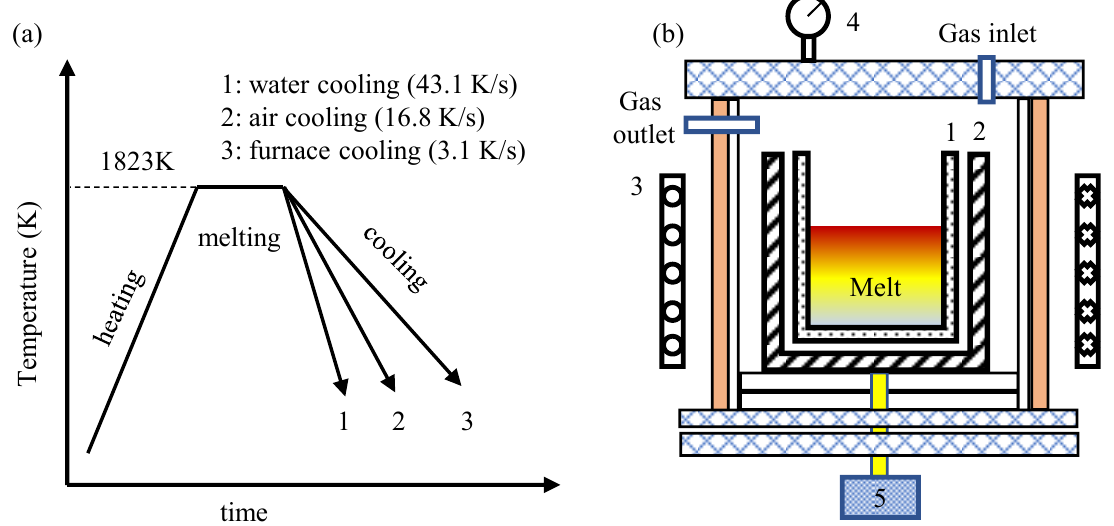
Figure 1. Schematic illustrations of ( a ) the thermal traces of the samples and ( b ) the high-frequency induction furnace: 1. silica crucible, 2. magnesia lining, 3. induction coil, 4. vacuum meter, 5. thermocouple.